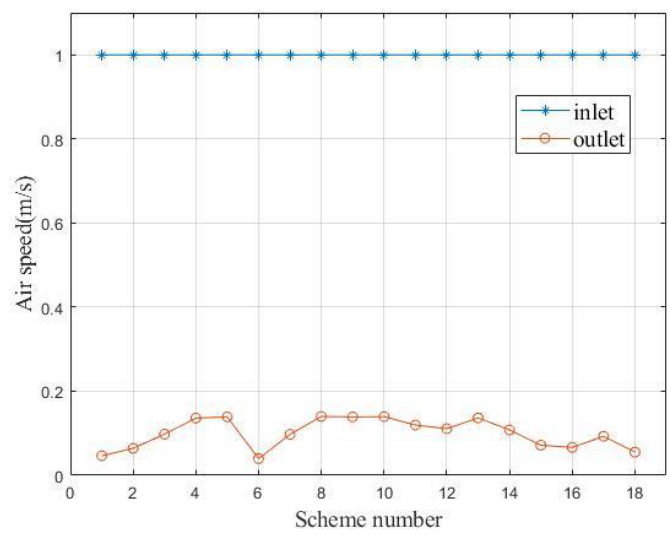
Figure 14. The air speed at the inlet and outlet based on inlet and outlet position.